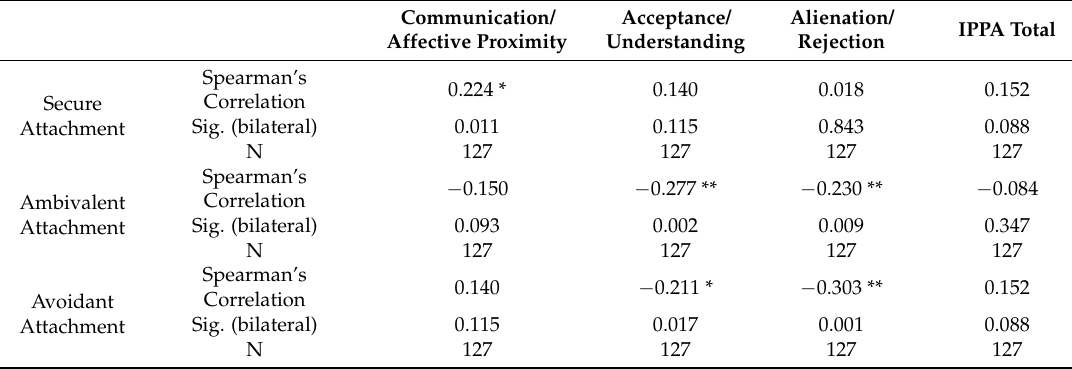
Table 5. Childhood-Attachment subscale (IACA) and the student–teacher relations subscale (IPPA), regarding the ACC.